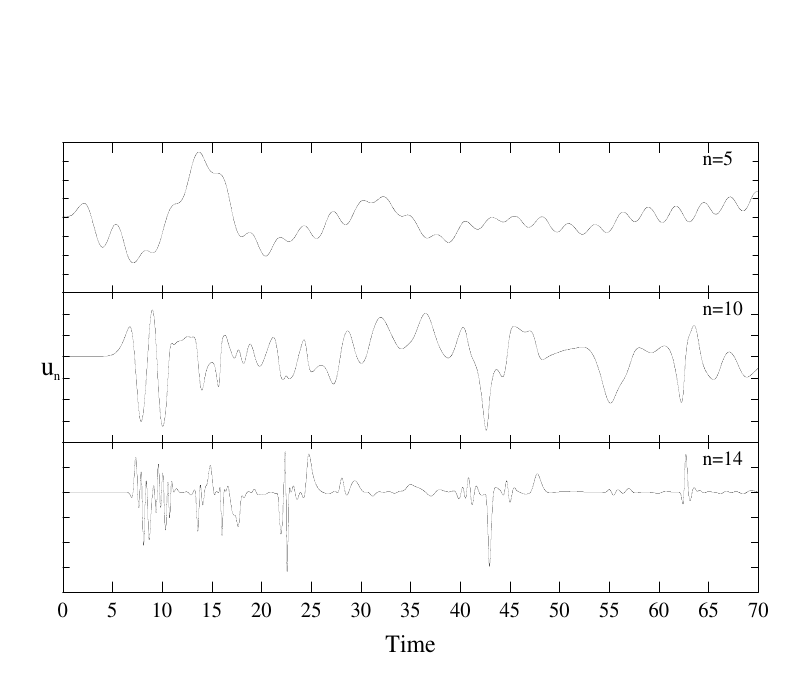
Figure 89: Time behavior of the real part of velocity variable 𝑢 𝑛 ( 𝑡 ) at three different shells 𝑛 , as indicated in the different panels.